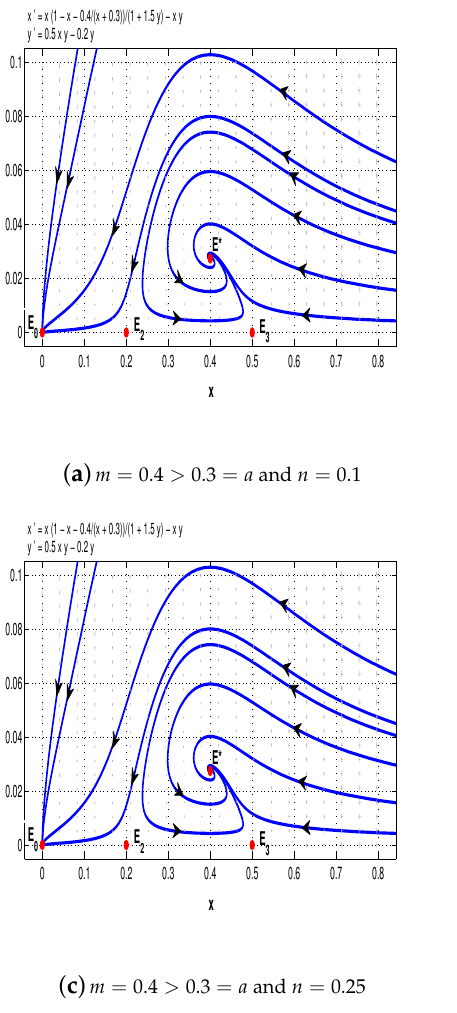
Figure 7. ( a ) With m = 0.4 > 0.3 = a and n = 0.1, there is a stable node E 0 , a saddle-node E 2 , and a saddle E 3 . ( b ) With m = 0.4 > 0.3 = a and n = 0.2, there is a stable node E 0 , two saddles E 2 and E 3 , and a stable node E ∗ . ( c ) With m = 0.4 > 0.3 = a and n = 0.25, there is a stable node E 0 , a saddle E 2 , and a saddle-node E 3 . ( d ) With m = 0.4 > 0.3 = a and n = 0.5, there is a stable node E 0 , a saddle E 2 , and a stable node E 3